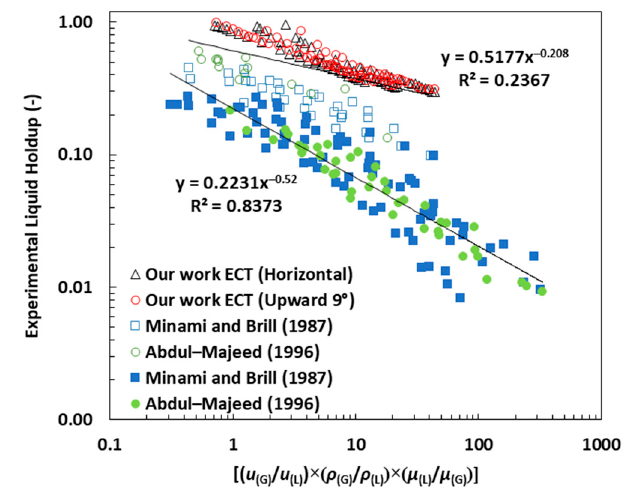
Figure 3. The experimental ε (L) expressed as a function of the dimensionless quantities in Equation (7): logarithmic comparison of ε (L) (i.e., 310 data points) obtained from this work, [51,53].